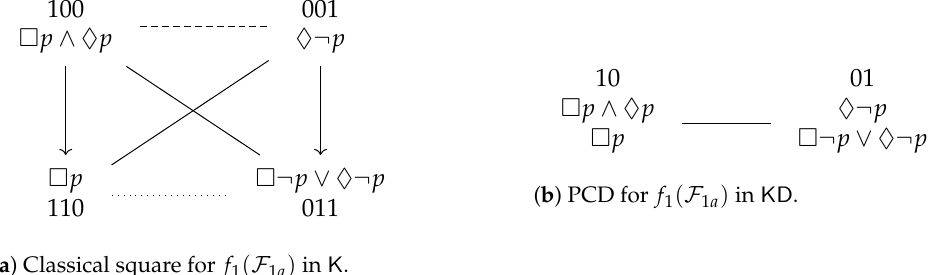
Figure 7. Aristotelian diagrams for f 1 ( F 1 a ) = { (cid:3) p ∧ ♦ p , (cid:3) p , ♦ ¬ p , (cid:3) ¬ p ∨ ♦ ¬ p } in two normal modal logics.